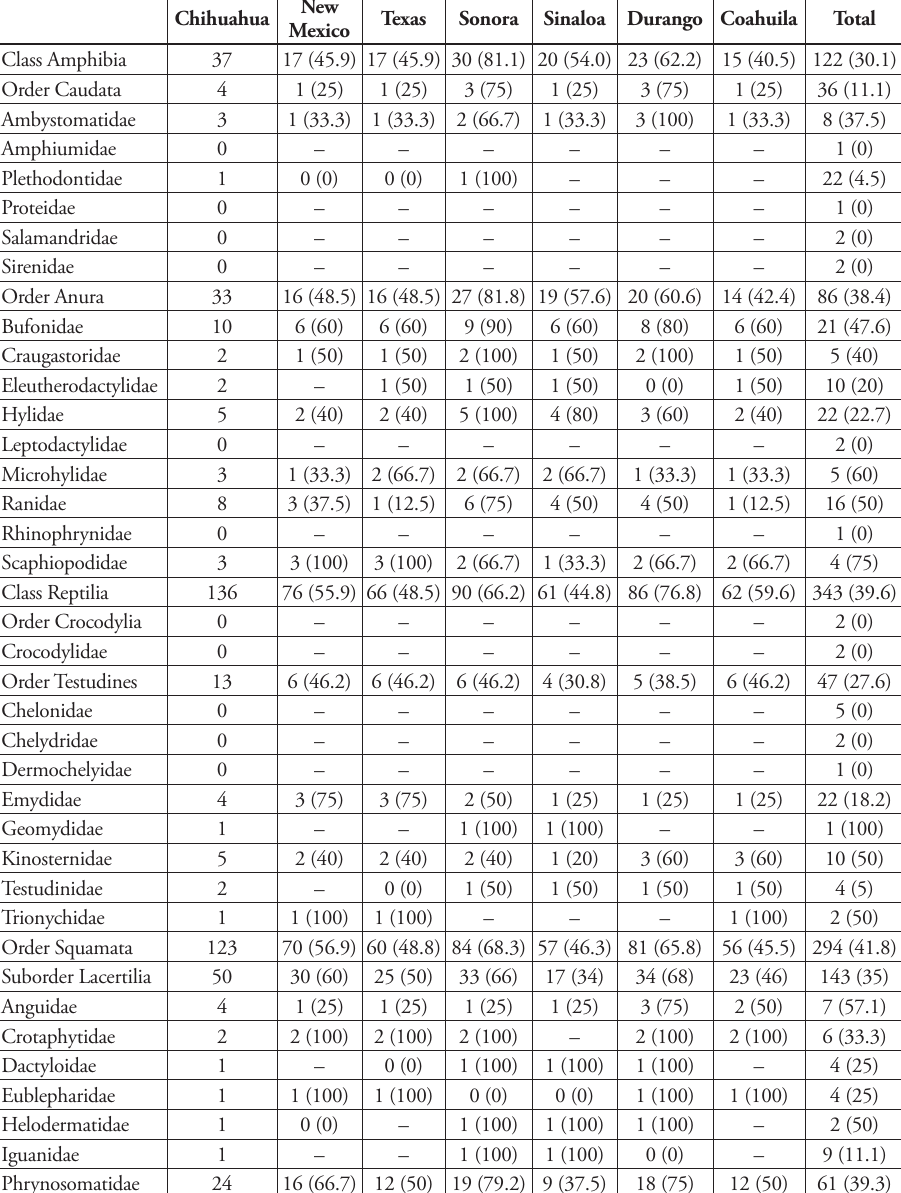
Table 4. Summary of the numbers of species shared between Chihuahua and neighboring Mexican and American states (not including introduced species). The percent of Chihuahuan species shared by a neigh- boring state are given in parentheses. Total refers to the total number of species found in Chihuahua and all the neighboring states (i.e., regional species pool) and the number in parentheses in this column is the percent of the regional species pool found in Chihuahua. -- indicates either Chihuahua or the neighboring state has no species in the taxonomic group, thus no value for shared species is